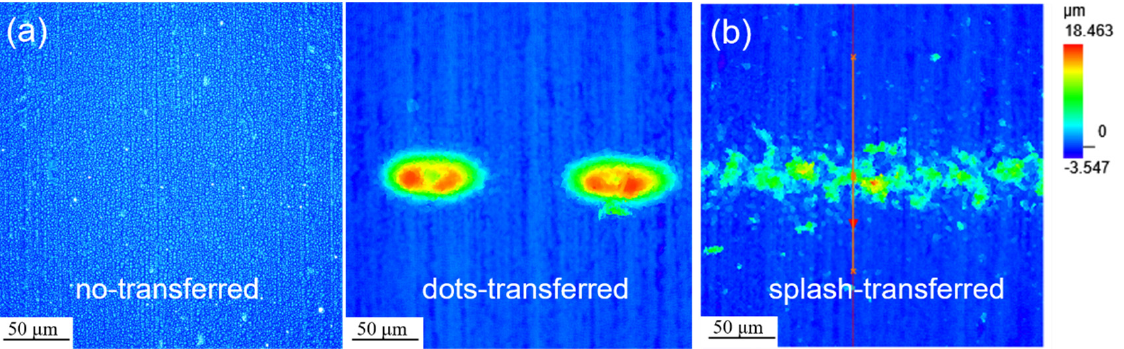
Figure 3. Two-dimensional morphology of the formed lines under lower and higher laser fluences obtained by LSCM. ( a ) lower fluences: no-transferred or dots transferred, ( b ) much higher fluences: splash-transferred.